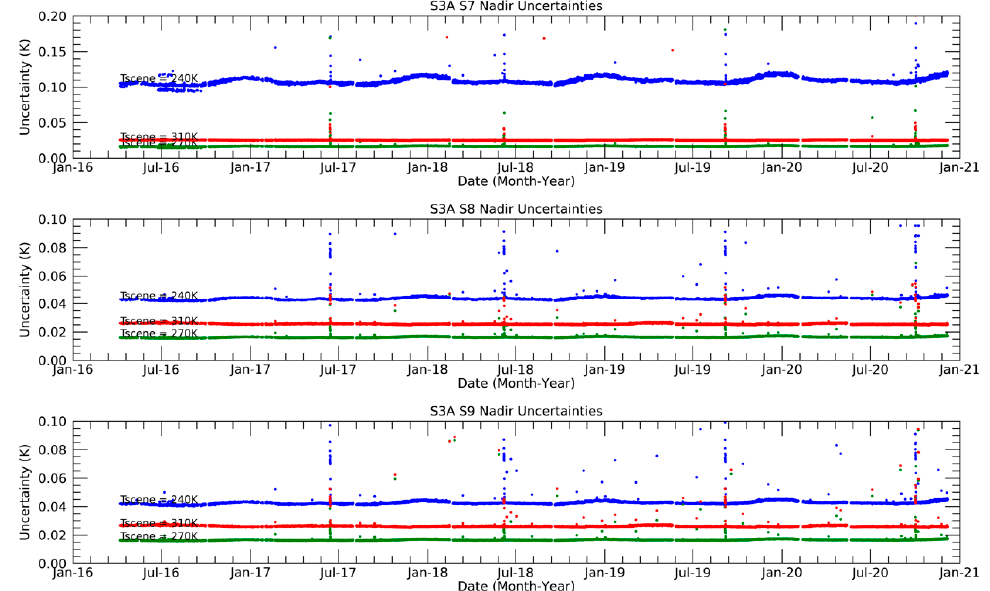
Figure 14. Time series for the period from March 2016 to December 2020 of SLSTR-A Thermal Infrared Radiometric. Uncertainties (systematic effects) for scene temperatures of 240 K (blue), 270 K (green) and 310 K (red).